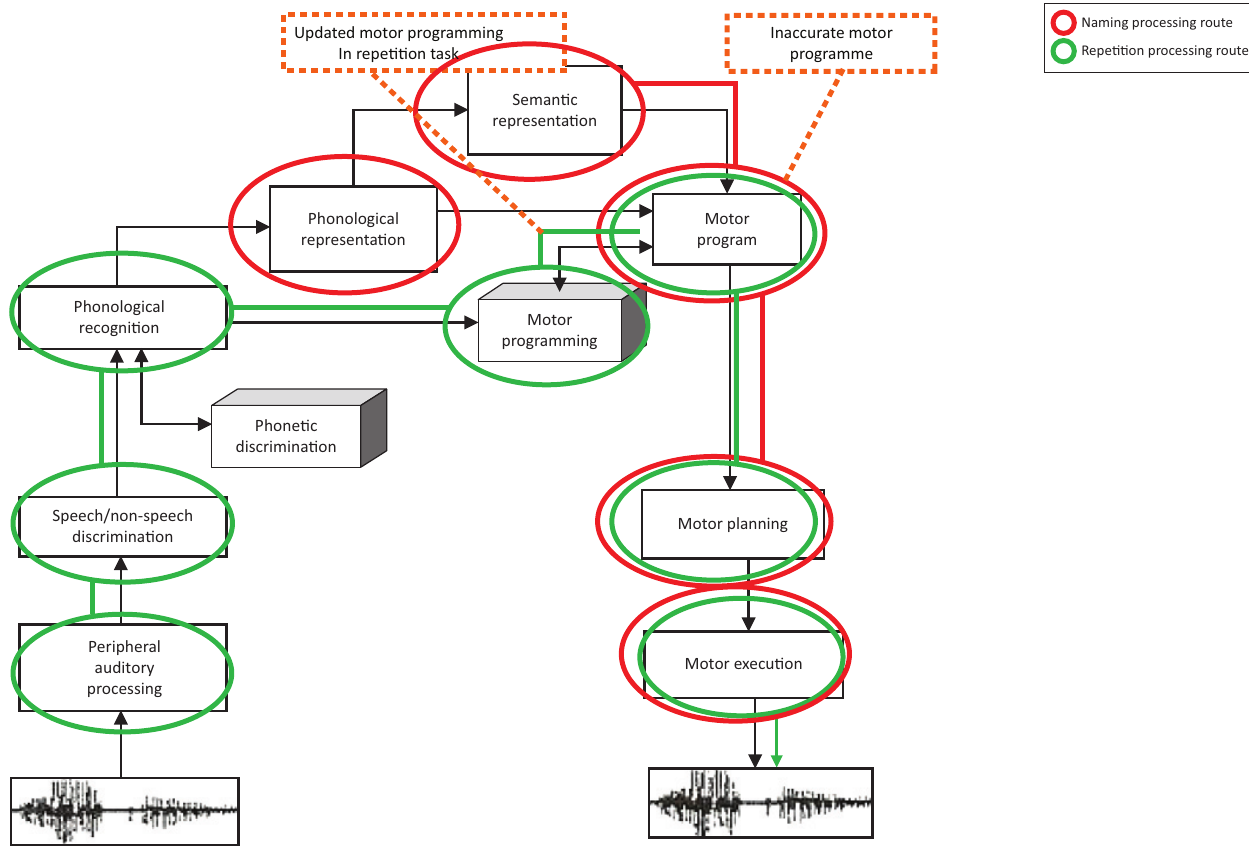
FIGURE 4: Possible areas of difficulty for iwotshi [watch] (Child